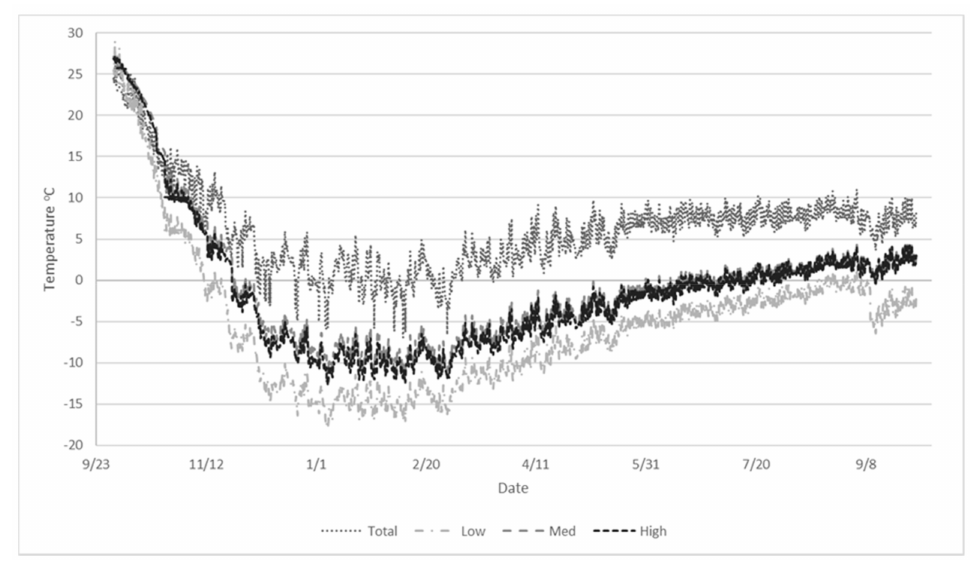
Figure 3. The average values of the temperature sensors for each of the three cable configurations defined in Figure 2 as low, medium, and high, versus the average temperature calculated for the numerical solution (total) for a one-year controlled aeration simulation of 1346 MT of maize beginning 1 October, 2014. The fan was turned on whenever the ambient air temperature was cooler than the mid-point sensor in the core of the grain mass.